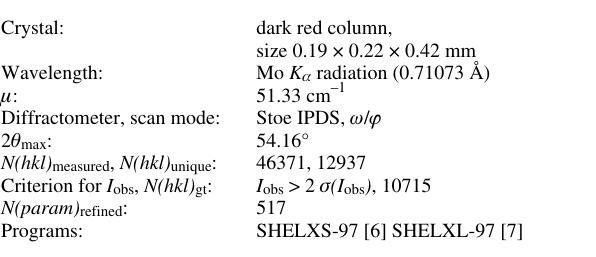
Table 1. Data collection and handling.